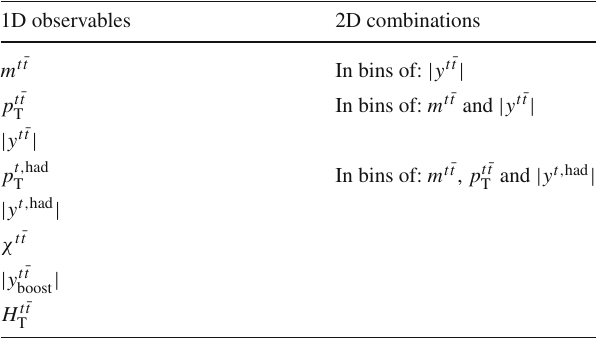
Table 6 The single-differential and double-differential spectra, mea- sured in the resolved topology at parton level 1D observables